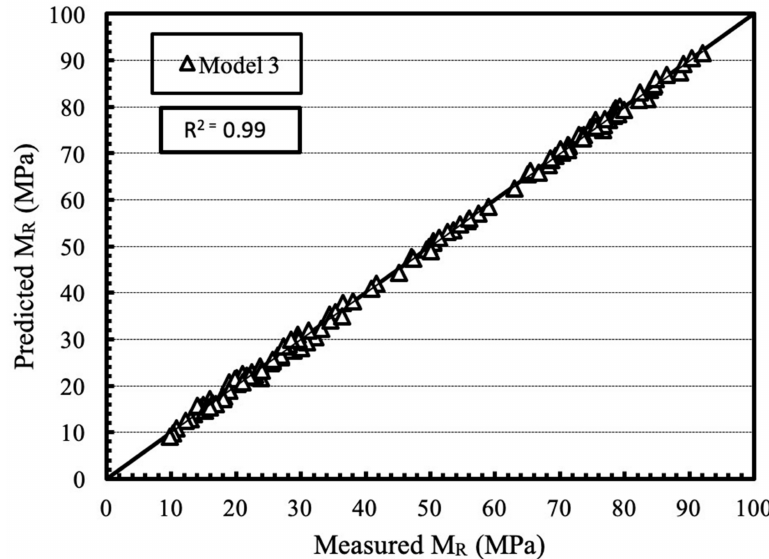
Figure 18. Plot between predicted and measured M R values using model 3 for all the mixtures tested under unsoaked and soaked